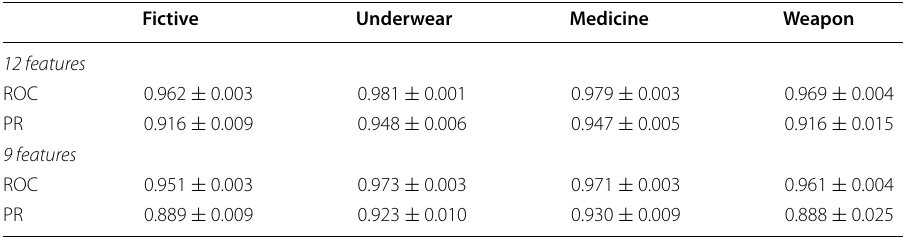
The average and standard deviation were calculated based on the 100 classifiers